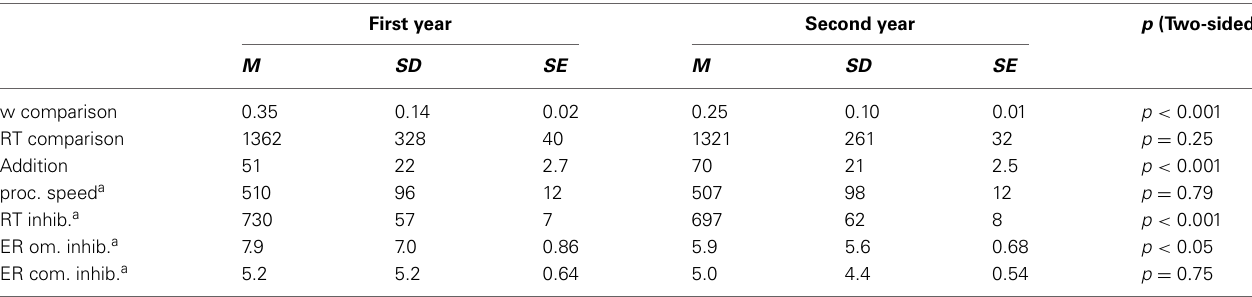
Table 1 | Comparison of first and second-year performance (paired-sample t -tests) with respect to the internal Weber fractions (w comparison), reaction times (in ms) in the non-symbolic numerical comparison task (RT comparison), the addition task, reaction times (in ms) in the visual detection task (proc. speed) as well as reaction times (in ms), omission and commission errors (in %) in the inhibitory control task (RT inhib., ER om. inhib., ER com.